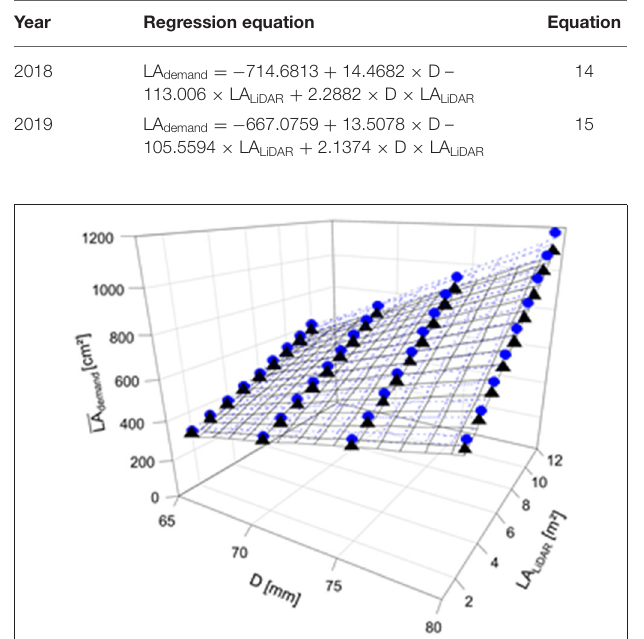
FIGURE 7 | Mean LA demand per fruit ( 2018 LA demand , 2019 LA demand , cm ² ) considering the four target fruit diameters (D) of ‘Gala’/M.9 apple in 2018 (gray circle, dotted line) and 2019 (black triangle, solid line) for the trees with different total LAs (LA LiDAR , m ² ) in the period of 15 d before and after the highest daily C-requirement per fruit (2018: 86–116 DAFB; 2019: 77–107 DAFB).